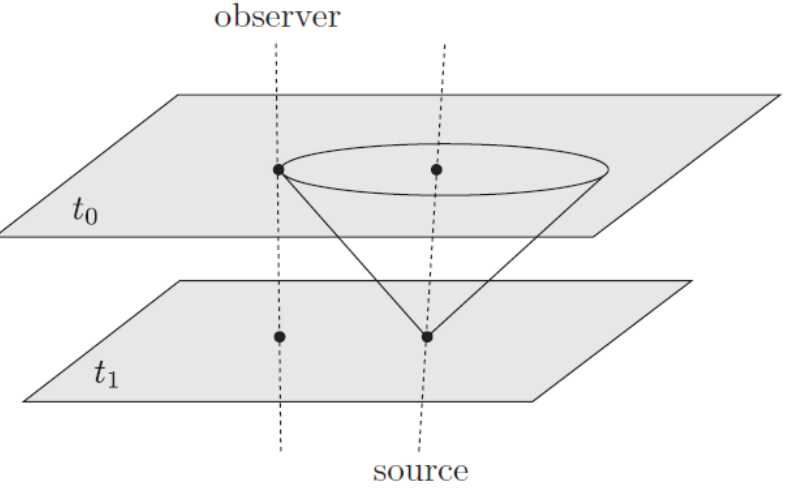
Figure A4. Figure that helps with the definition of Luminosity distance. Adapted from: